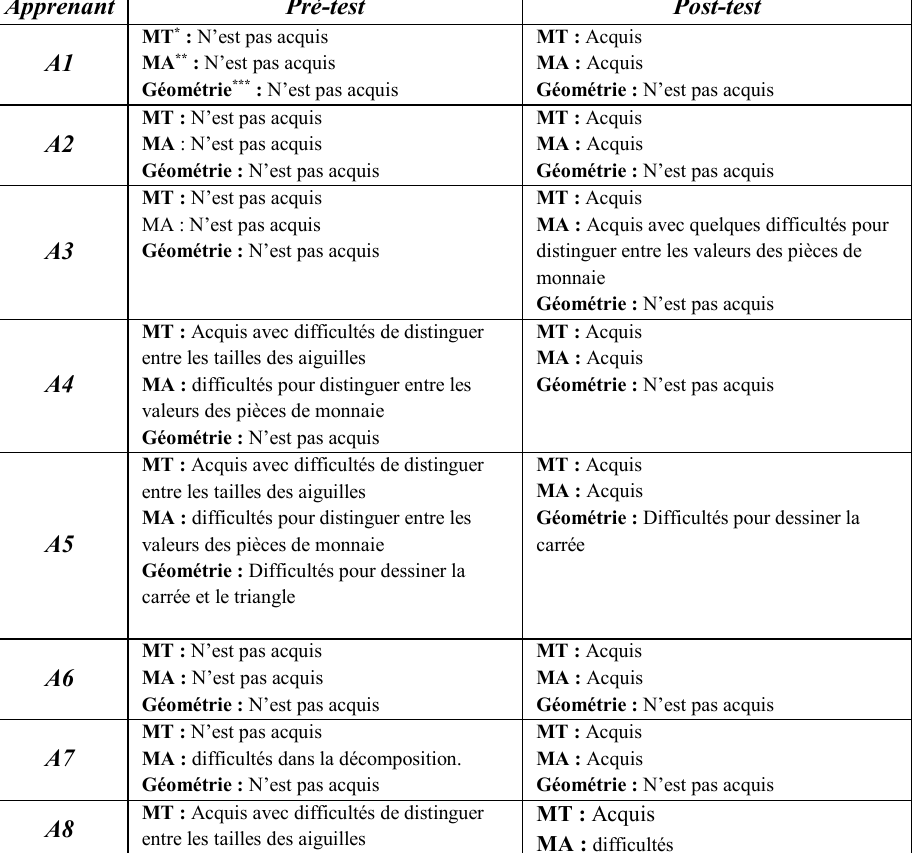
Tableau 2 : Les résultats du pré et du post-test de l’échantillon expérimental ( MT : Distinguer entre les aiguilles ; MA : Distinguer entre les pièces de monnaie entre 5 millièmes et 5 dinars ; Géométrie : Dessiner des formes géométriques : cercle, carrée et